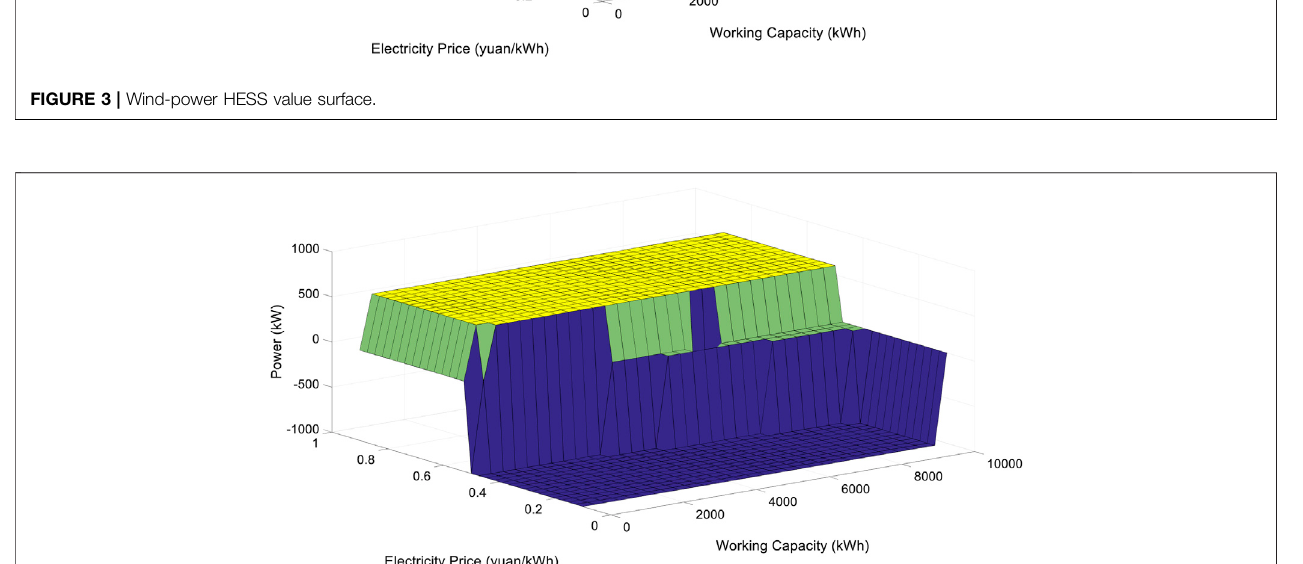
FIGURE 4 | Control surface of wind-power